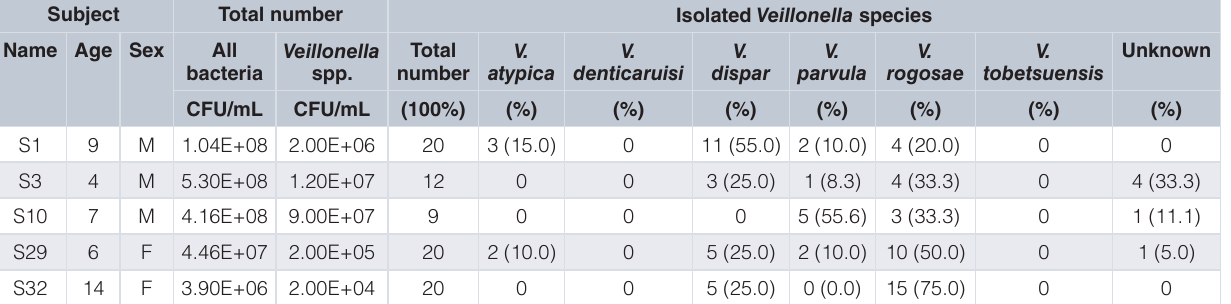
Table 2. Ratio of the number of isolates of each species to the total number of Veillonella isolate in saliva from the moderate oral hygiene group. The colony-forming units (CFU) of all anaerobic bacteria on the brain heart infusion agar and Veillonella strains on Veillonella agar (detection limit <0.1% of the total count). The total of Veillonella isolates identified by the Veillonella genus-specific PCR primer. Individual species as a percentage of the number of isolates identified by one-step PCR with the species-specific primer sets for each subject ( n = 5) from saliva of the moderate oral hygiene